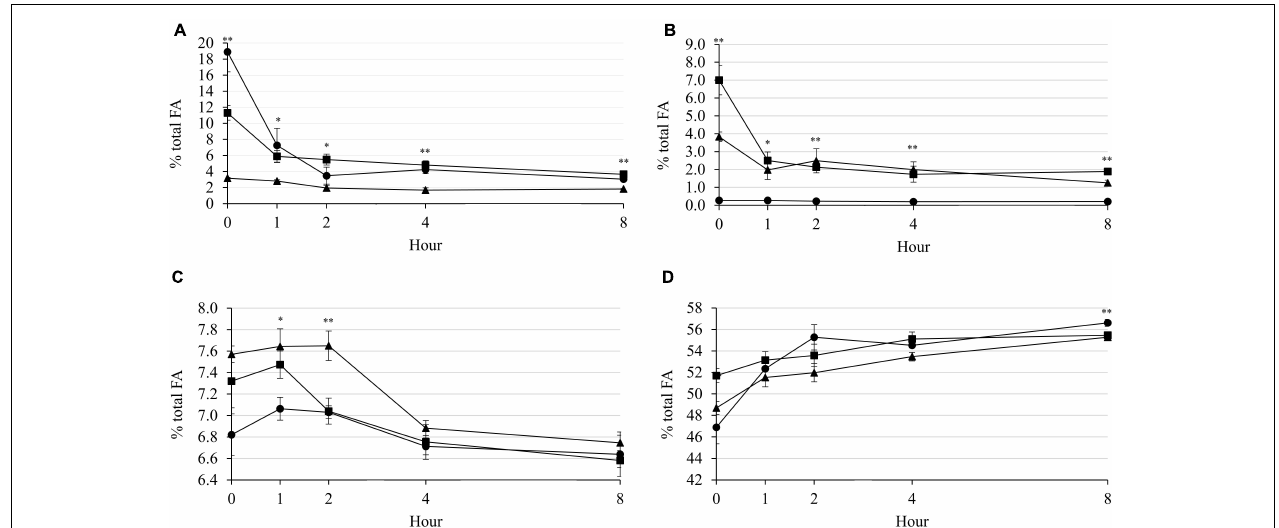
FIGURE 4 | Changes in C18:2n-6 (A) , C18:3n-3 (B) , C18:1 cis -9 (C) , and C18:0 (D) concentrations (%, FA) during rumen incubation with FAs for 8 h. Diet with C18:2n-6, LA (filled circles); diet with C18:3n-3, LNA (filled triangles); and diet with the mixture of C18:2n-6 and C18:3n-3 at a ratio of 1:1 (filled squares). The respective significance levels of the supplementary treatment, incubation period, supplementary treatment × incubation period, and SEM for concentrations of C18:2n-6, C18:3n-3, C18:1n-9, and C18:0 are P < 0.001, P < 0.001, P < 0.001, and SEM = 1.915; P < 0.001, P < 0.001, P < 0.001, and SEM = 1.111; P < 0.001, P = 0.001, P = 0.218, and SEM = 0.306; and P < 0.001, P < 0.001, P = 0.036, and SEM = 1.741. Different symbols at the same hour differ significantly. ∗ P < 0.05; ∗∗ P <